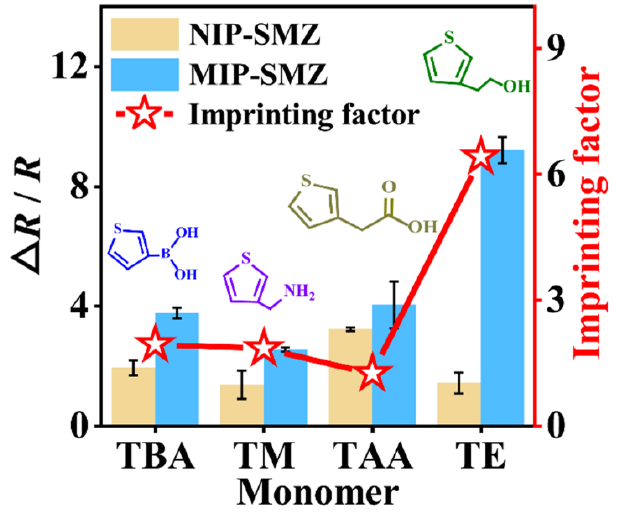
Figure 2. EIS responses (bar charts) and imprinting factors (line charts) of several MIPs prepared with different monomers towards target sulfamethizole (SMZ, 0.1 μM).